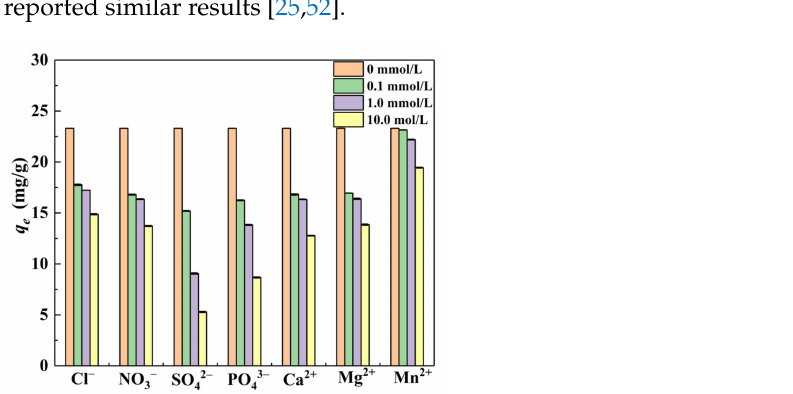
Figure 7. Effects of coexisting ions on Cr(VI) equilibrium adsorption capacity ( q e ).